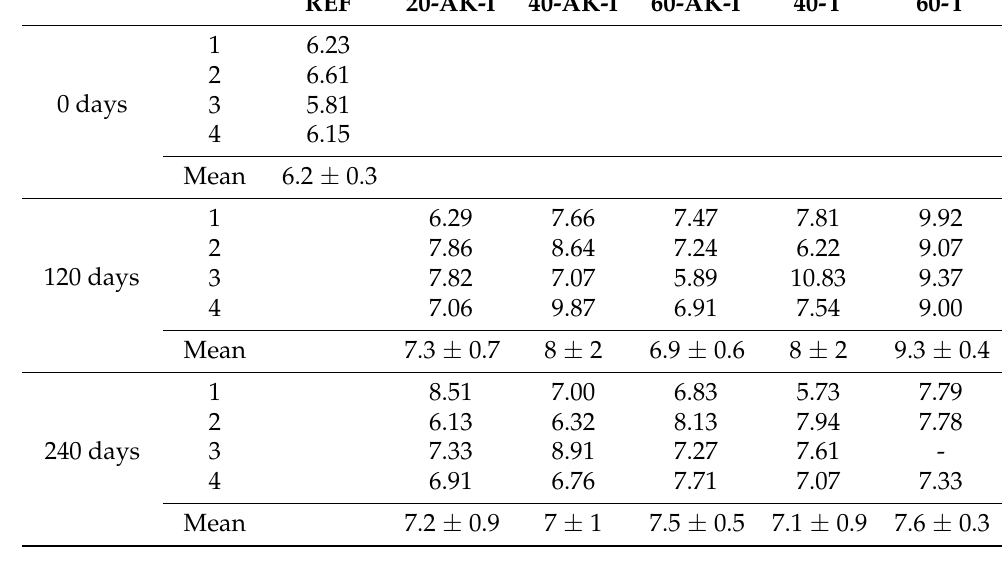
Table 10. Results of pull-out tests performed on reference and aged specimens.